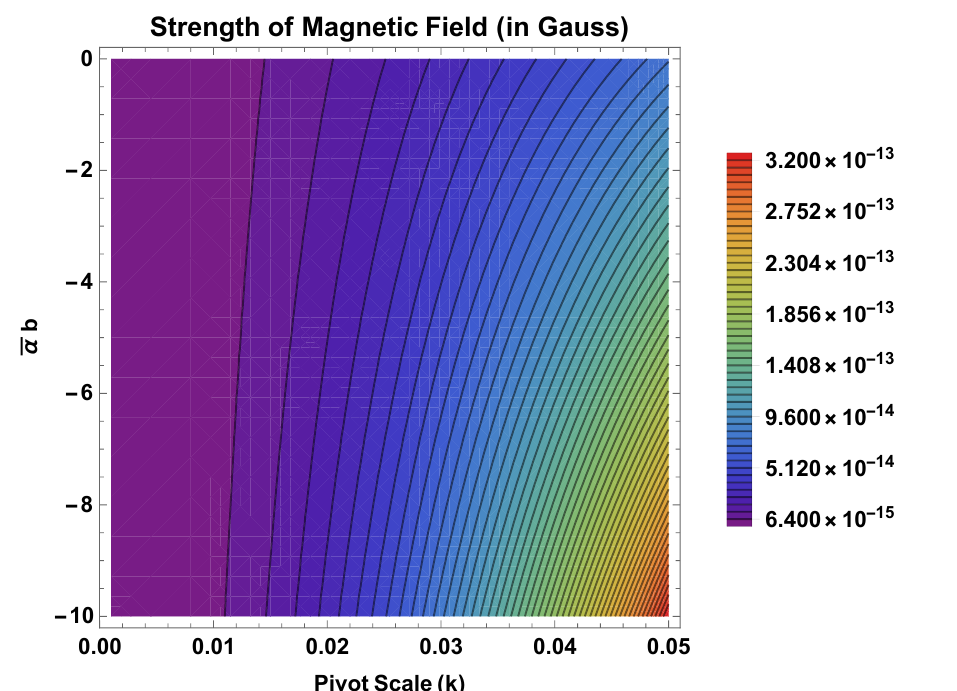
Figure 3. The above figure demonstrates the magnetic field strength in Gauss in the present epoch with positive values for ν (determined by the parameter | ¯ α b | ), with both the pivot scale k (in Mpc − 1 ) and the parameter ¯ α b . Each contour depicts one constant value of the magnetic field. As evident from the colour coding the strength of the magnetic field varies from B 0 ∼ 10 − 13 Gauss for large k and | ¯ α b | to B 0 ∼ 10 − 15 Gauss for small k and small | ¯ α b | .